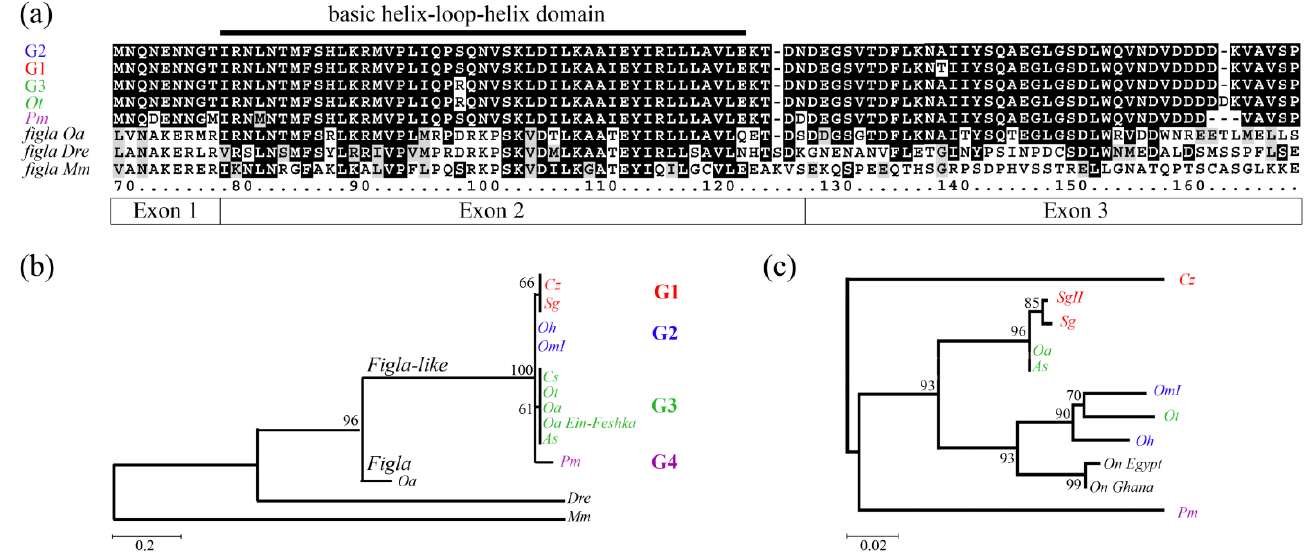
Figure 2. Protein sequence and phylogenetic tree of the figla-like gene. ( a ) An alignment of the predicted proteins encoded by figla-like and figla proteins. The alignment includes five shorter polypeptides, which are of figla-like protein groups (G1–4). Protein group G1 (blue) consists of the identical polypeptides of C. zillii ( Cz ) (Nucleotide accession number: OW742498) and S. galilaeus ( Sg ) (Nucleotide accession number: OW742804). Protein group G2 (red) consists of the identical polypeptides of O. urolepis hornorum ( Oh ) (Nucleotide accession number: OW740593) and O. mossambicus ( OmI ) (Nucleotide accession number: OW739941). Protein group G3 (green) consists of the identical polypeptides of Chitralada strain ( Cs ) (Nucleotide accession number: OW739608), O. aureus genomic build ( LOC116310109 ), O. aureus from Ein-Feshka ( Oa Ein-Feshka ) (Nucleotide accession number: OW770257), and Amherst strain ( As ) (Nucleotide accession number: OX031319). O. tanganicae ( Ot , green) (Nucleotide accession number: OW739839) is shown out of G3, as its sequence differs by an additional D residue. P. mariae ( Pm , purple) (Nucleotide accession number: OW742294) is the only member in G4. The alignment also includes three partial figla polypeptides for Oa (Protein accession number: XP_039476449.1), Danio rerio ( Dre ) (Protein accession number: NP_944601.2), and Mus musculus ( Mm ) (Protein accession number: NP_036143.1). Dashes indicate gaps introduced by the alignment program. Identical amino-acid residues in at least four of eight sequences are indicated by a black background. White boxes indicate nonconservative amino-acid changes between the proteins, whereas gray boxes indicate conservative changes. The black line represents the position of a 45-long basic helix – loop – helix (bHLH) domain found in factor-in-the-germline-alpha ( FIGLA ) proteins. The amino-acid numbering follows that of the full alignment of figla with figla-like genes (Figure S2). Below, exon – intron boundaries are delineated. ( b , c ) Comparison between the phylogenetic trees of figla-like predicted proteins and barcode cox1 DNA sequences. The trees were generated by MEGAX [66] using the Maximum Likelihood method using models with the best Bayesian information criterion (BIC) levels and default setting (5 categories, +G, parameter = 0.2071). Numbers at tree junctions indicate the percentage of trees that correspond to the consensus bootstrap tree (500 replicates) using MUSCLE. ( b ) JTT matrix-based model with a discrete Gamma distribution was used to model evolutionary rate differences among the figla-like predicted proteins. The scale on the X -axis represents the distance in number of amino-acid substitutions per site. ( c ) Hasegawa – Kishino – Yano model discrete Gamma distribution [67] was used to study evolutionary rate differences among the mitochondrial DNA sequences. The scale on the X -axis represents the distance in number of nucleotide substitutions per site. Barcode sequences and accession numbers of O. niloticus ( On ) of Egyptian and Ghanaian origin and of others are provided in the Supplementary Materials (Table S3).